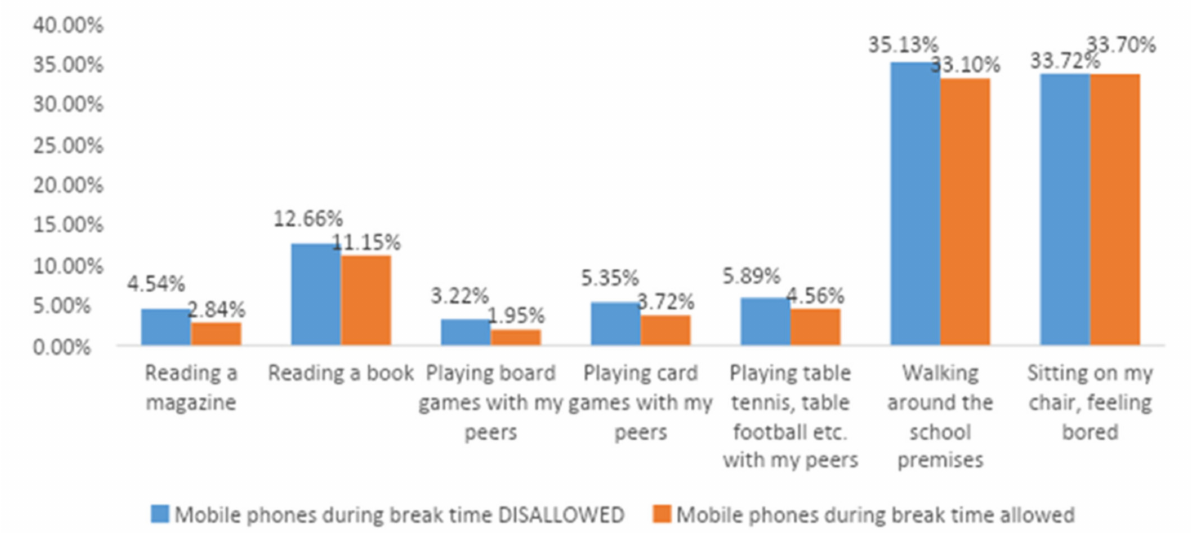
Figure 1. Activities carried out during break times depending on the availability of the mobile